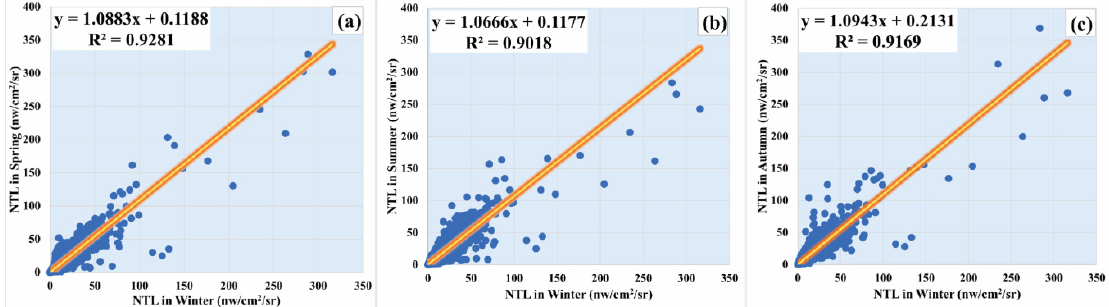
Figure 8. Linear relationship of filtered NTL intensity between winter and the other three seasons at the pixel scale: ( a ) spring–winter; ( b ) summer–winter; ( c ) autumn–winter.